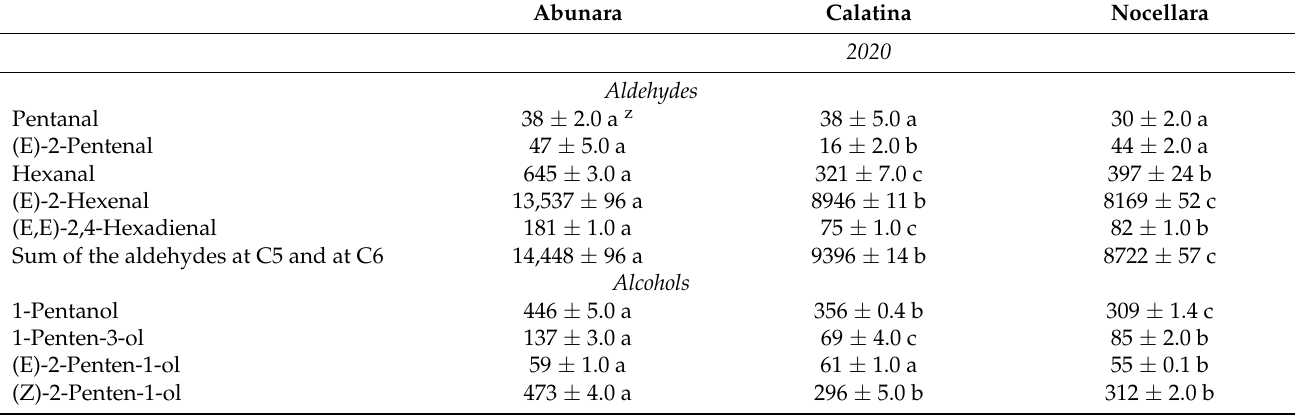
Table 5. Volatile composition ( µ g kg − 1 ) of virgin olive oils from ‘Abunara’, ‘Calatina’, and ‘Nocellara del Belice’ olive trees grown as central leaders at 2 × 5 m (CLx2, A), free palmette at 3 × 5 m (FPx3), globe vase at 4 × 5 m (GVx4), and polyconic vase at 5 × 5 m (PVx5) in the last two years of trials. Data are expressed as means ± standard deviation (n = 12). For each cultivar, data from different planting systems were pooled together.